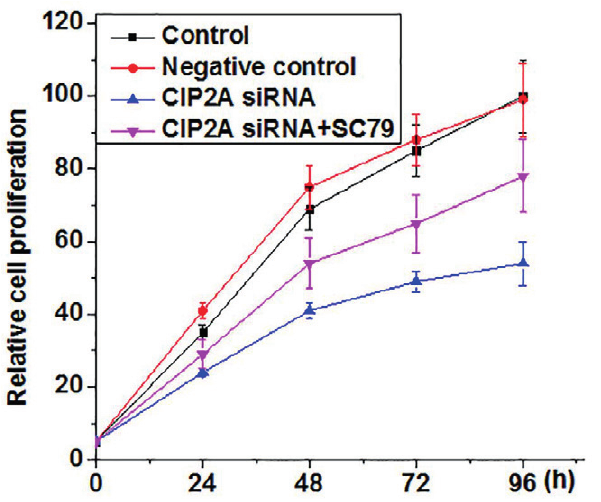
Fig. 6. Effects of CIP2A siRNA silencing on the proliferation of renal clear cell carcinoma cell line